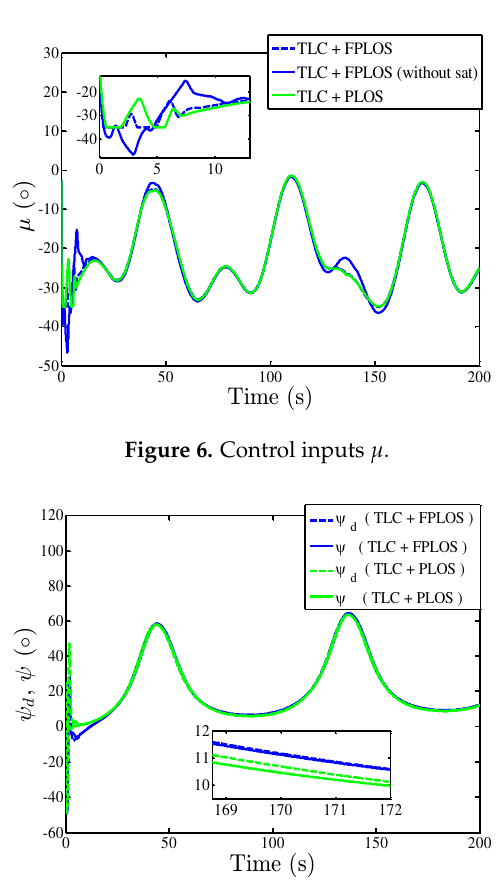
Figure 5. Path following performance.